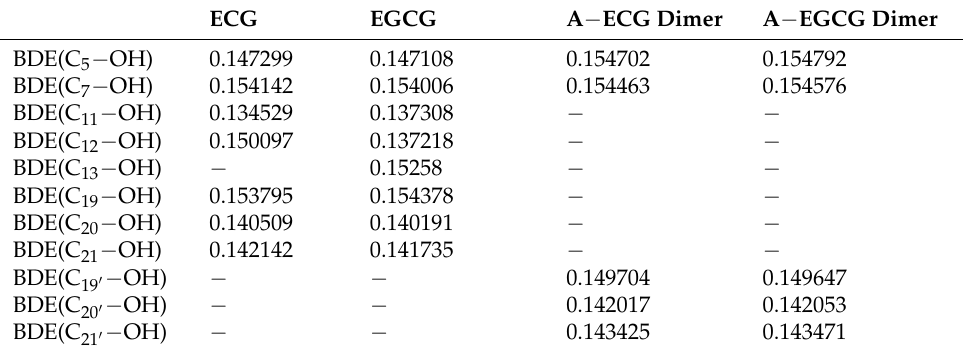
Table 4. The BDE of phenolic hydroxyl groups at different positions of four persimmon tannin characteristic structural units